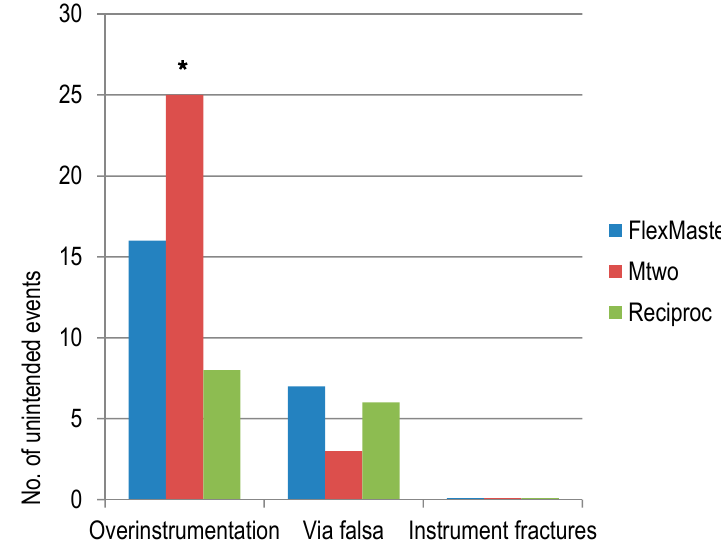
Figure 2. Unintended events during root canal preparation with the different strategies: crown-down (F), single-length (M), and single-file (R) ( χ 2 , N = 62 per group, * indicates significant differences with p < 0.01 between all groups).